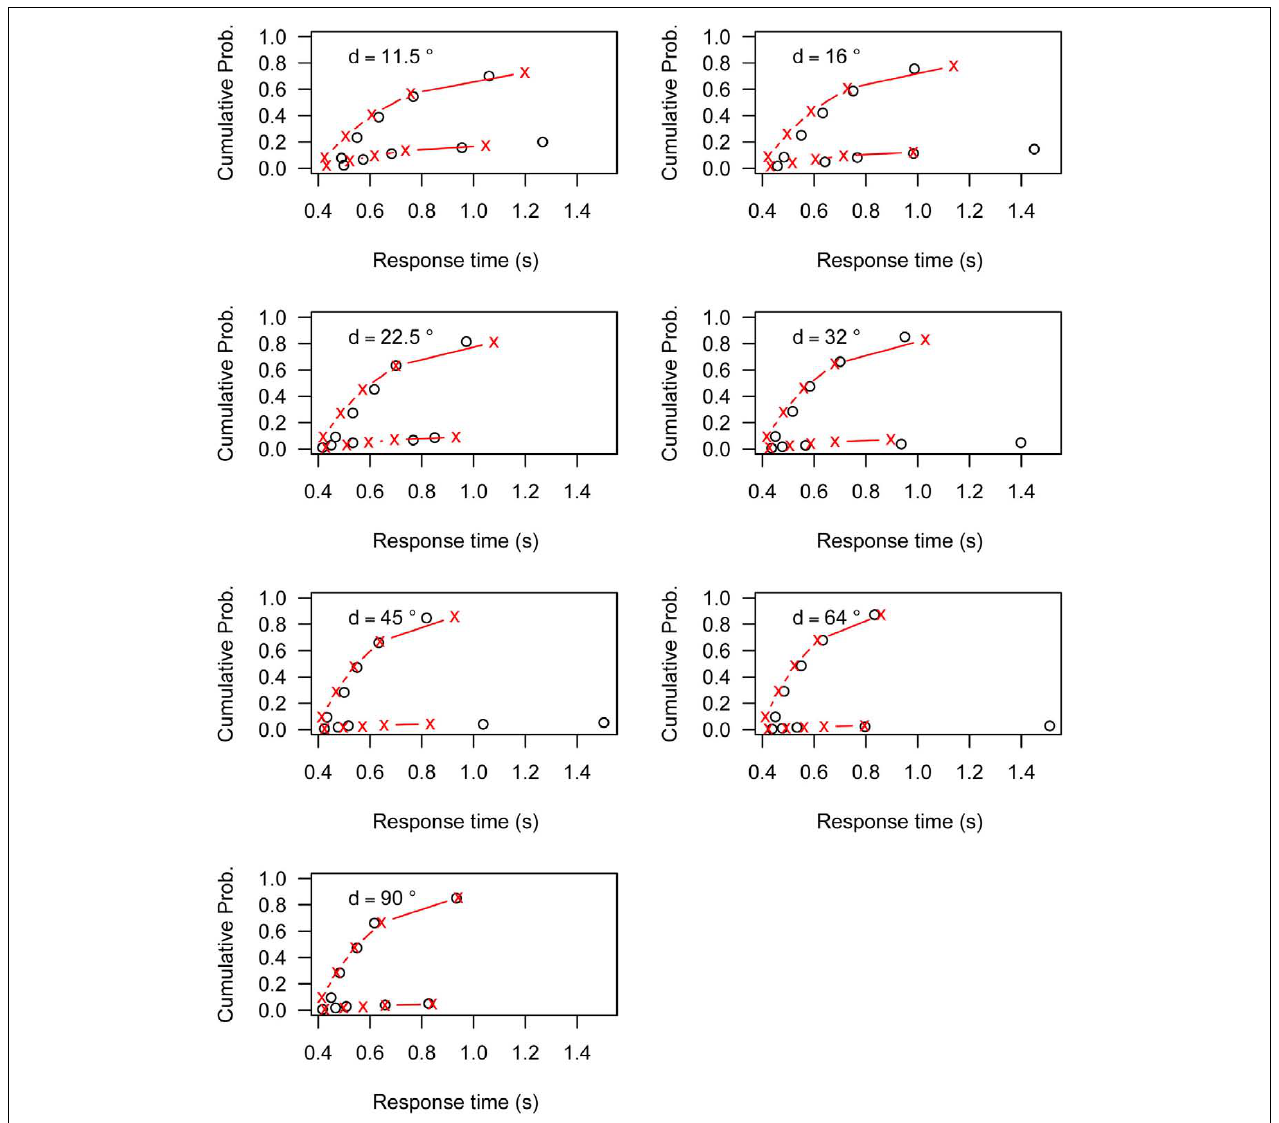
FIGUREA2 | LBA model fit for Participant